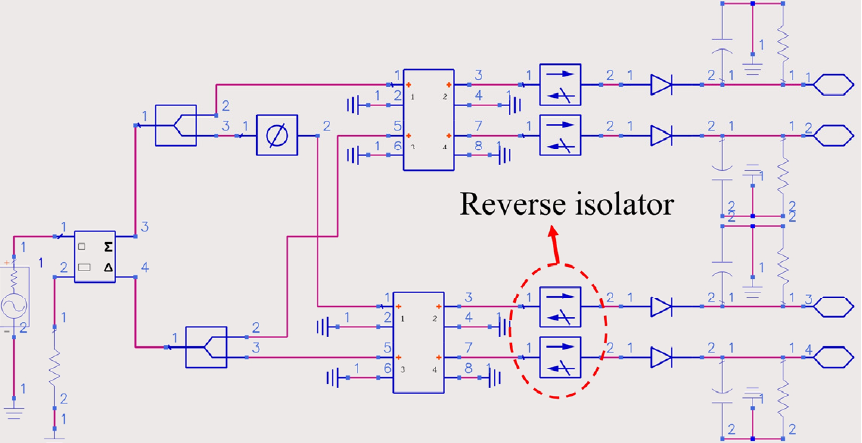
Figure 2. The simulation block diagram of the mismatch of the detection diode on the correlator in ADS.